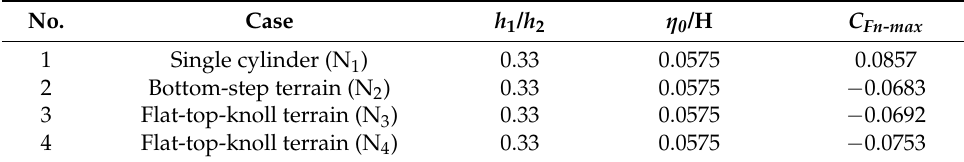
Table 2. Case introduction for different terrains.